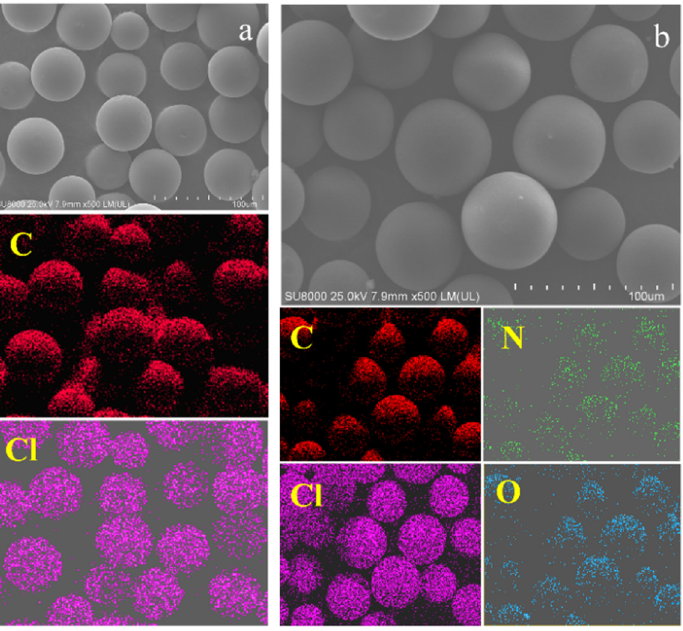
Figure 1. SEM images and the corresponding EDS mapping of PS-CH 2 Cl ( a ) and the elements of carbon and chlorine directly below ( a ) and the immobilized-HBA ( b ) and the elements of carbon, chlorine, nitrogen and oxygen directly below ( b ).